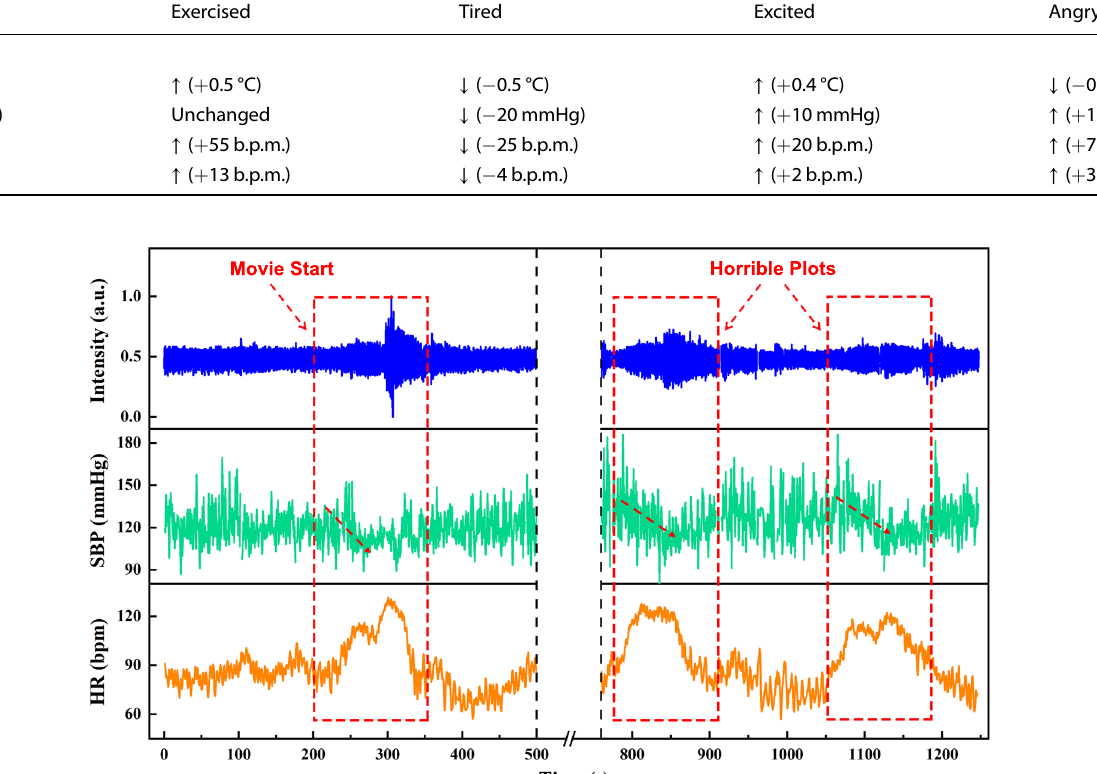
Fig. 6 Capturing transient state of startle. The transient state is captured by continuously monitoring the carotid artery wave (up curve), blood pressure (middle curve), and heart rate (down curve) when the tester is scared by a movie.